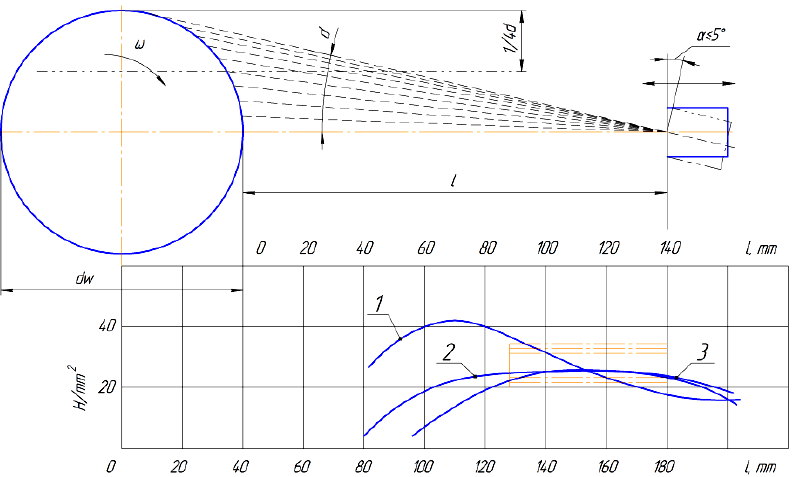
Figure 3. The dependence of the adhesion strength and the level of cracking of the coating on the spraying distance l at rotational speeds of 5 m/s (1), 1.5 m/s (2), and 0.15 m/s (3).